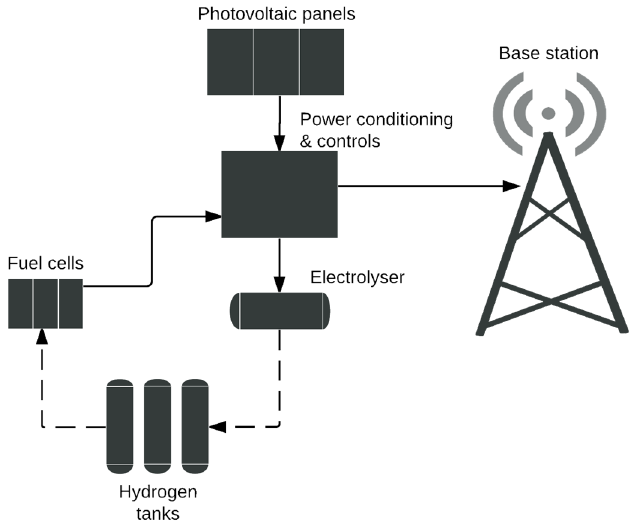
Figure 6. An example of a hydrogen-based energy storage system application present in a PV-hydrogen system for an off-grid base